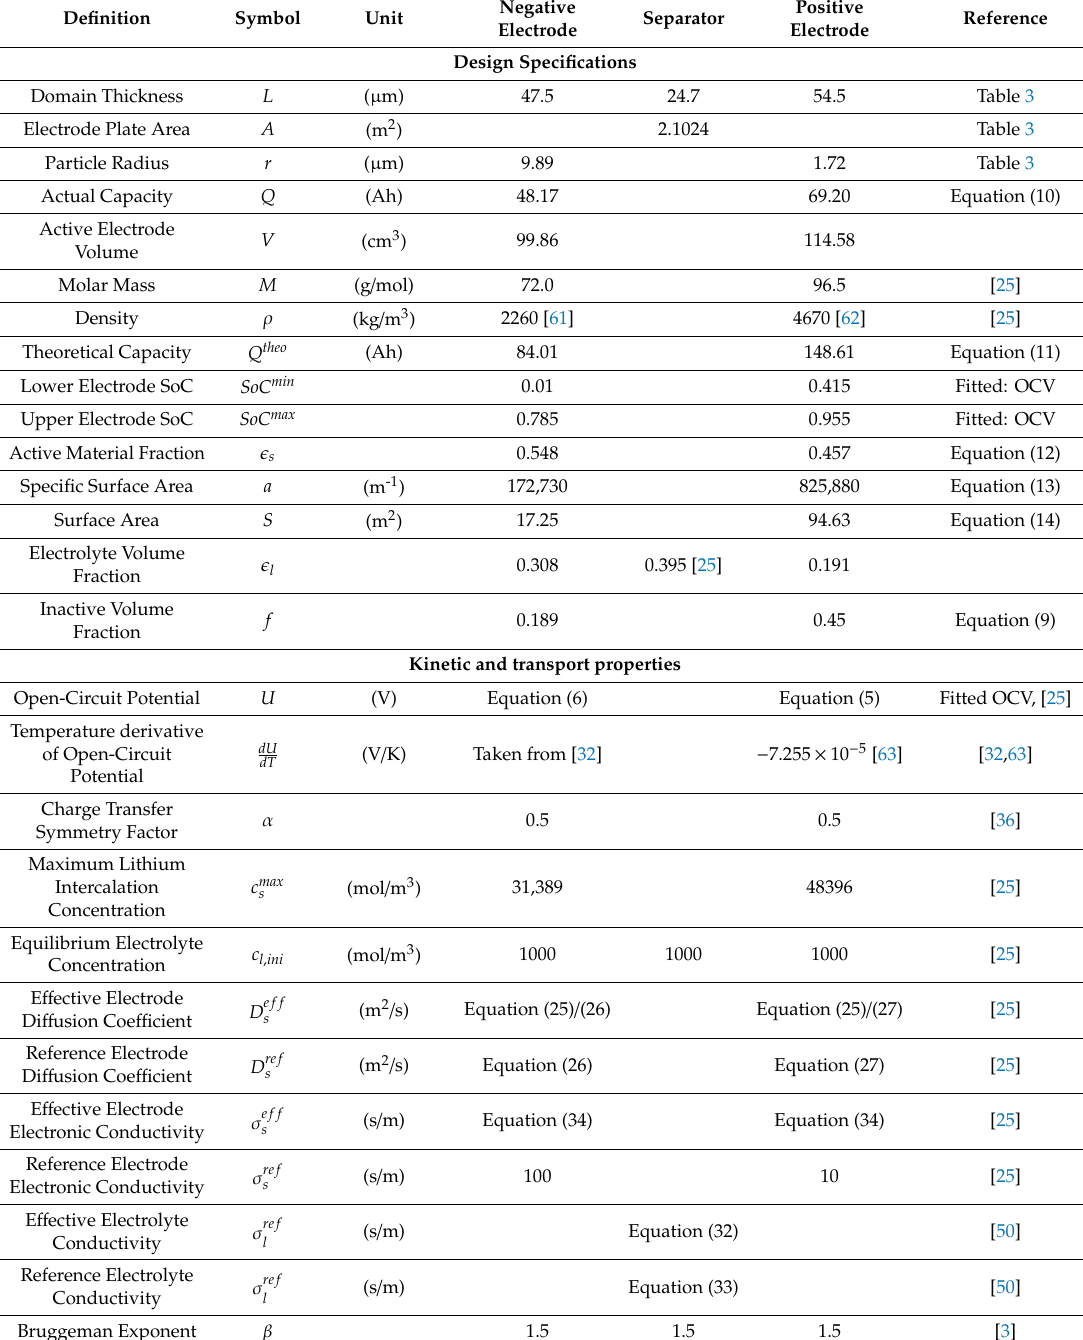
Table 6. Summary of all the material and cell properties resembling the analyzed battery